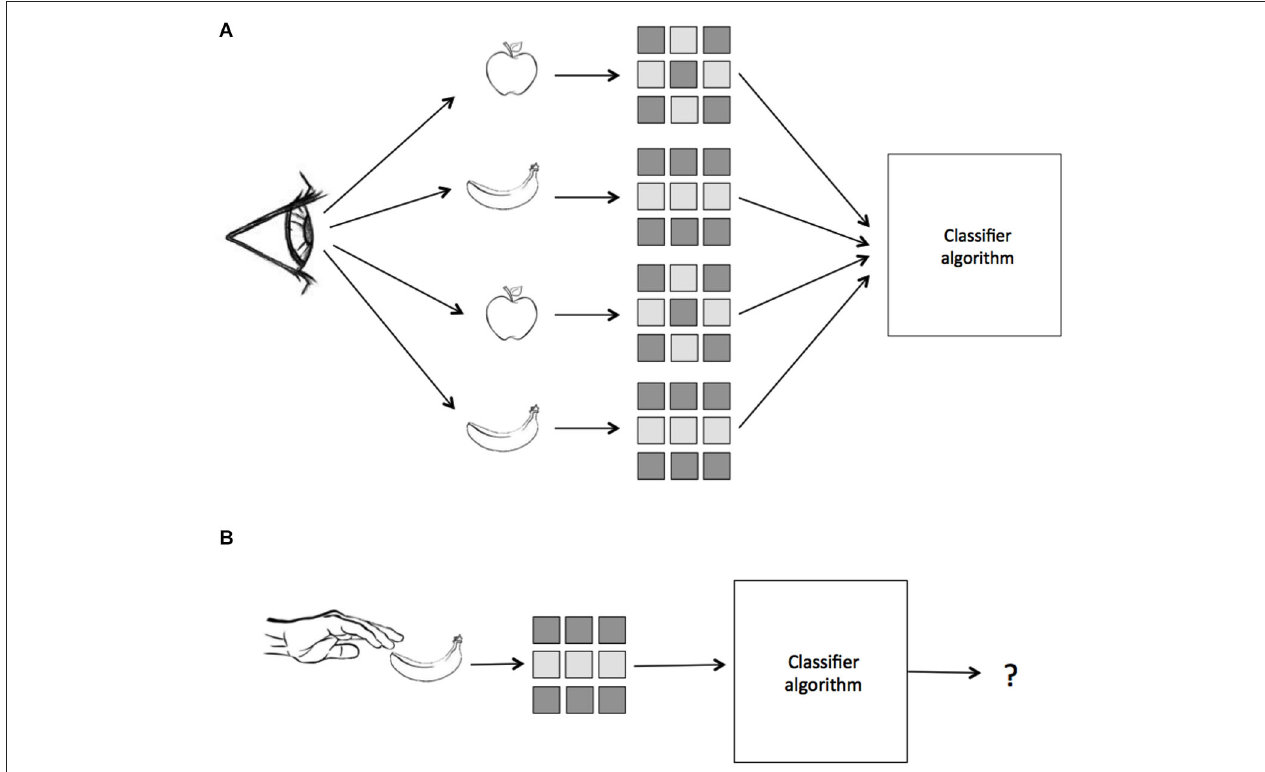
unlabeled data from when the subject touches the same objects and makes a prediction. If the classifier, which was trained on data from vision, can correctly identify the patterns evoked by touch, then we conclude that the representation is modality